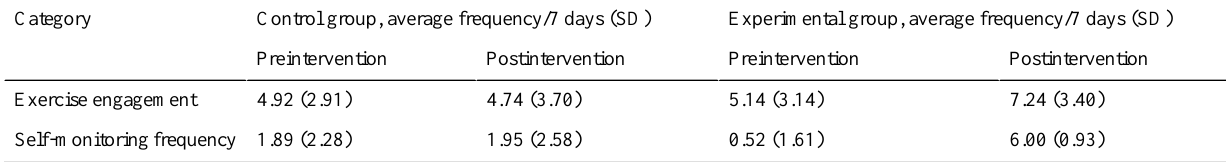
Table 5. Self-reported exercise and self-monitoring frequency.